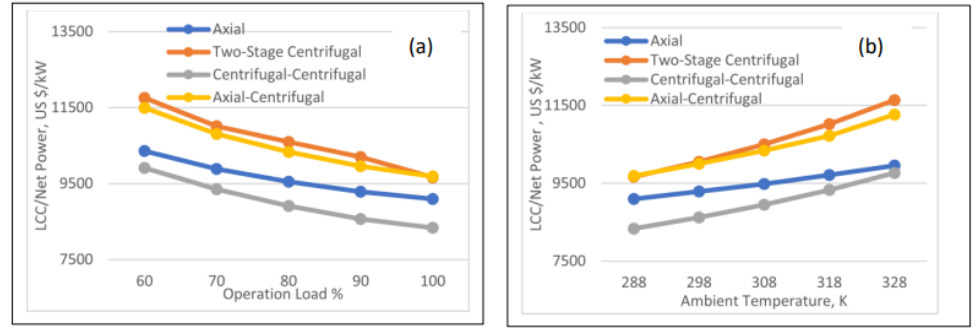
Figure 2. ( a ) Lifecycle costs at varying operating load, and ( b ) Lifecycle costs at varying ambient temperature.